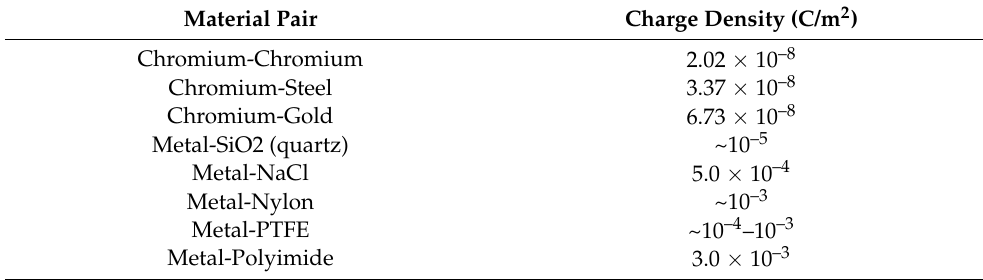
Table 2. Surface charge density after triboelectrification for different materials [48].